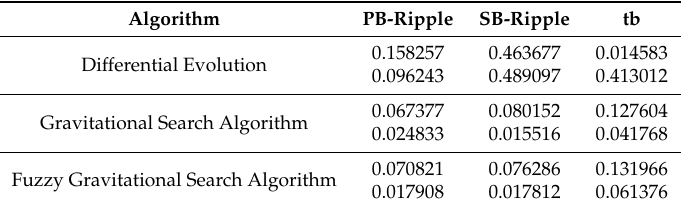
Table 6. Pass band ripple, stop band ripple and transition band of BP